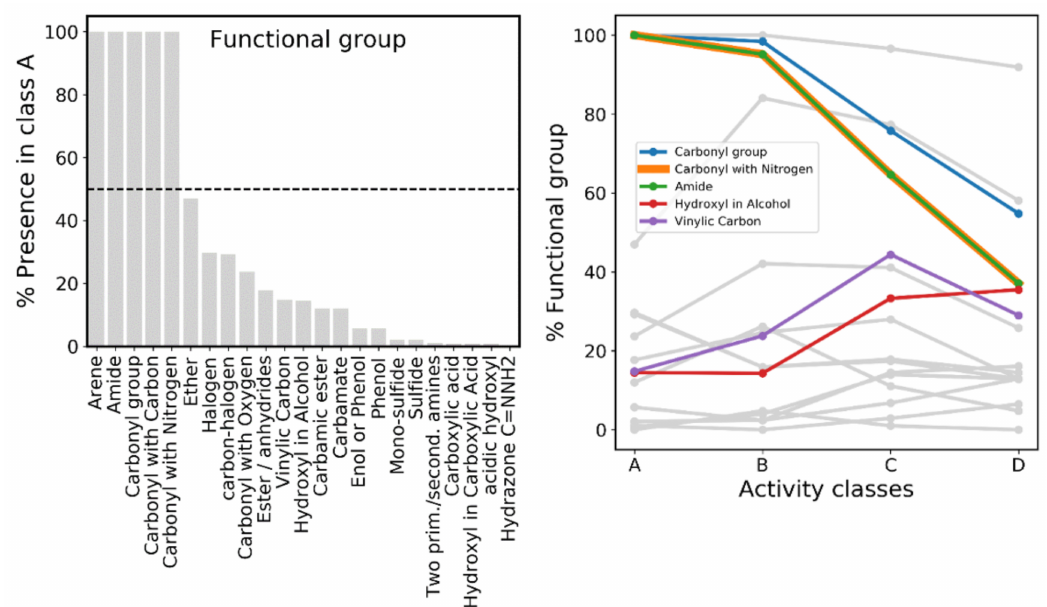
Figure 16. Frequency of common functional groups defined by Daylight SMARTS among proteasome inhibitors. (Left) Frequency (%) of functional groups in class A, sorted by descending order of percentage. Dotted line indicates 50% frequency. (Right) Functional groups highlighted according their (inverse or direct) correlation with activity. The gray lines in the background are the additional functional groups defined in the left plot, and correspond to groups with lower correlation with activity.